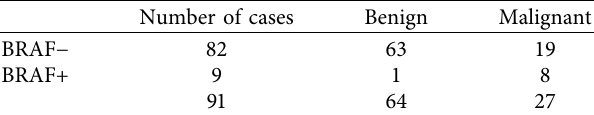
Table 3: BRAF status in TIR3